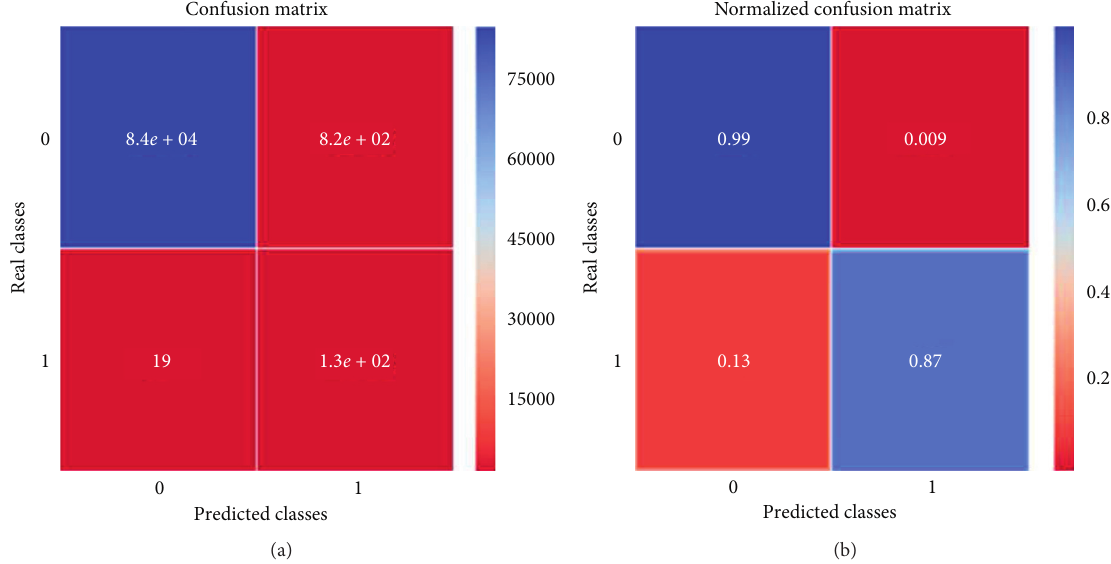
Figure 13: (a) Confusion matrix and (b) normalized confusion matrix for SMOTEENN+LSTM.